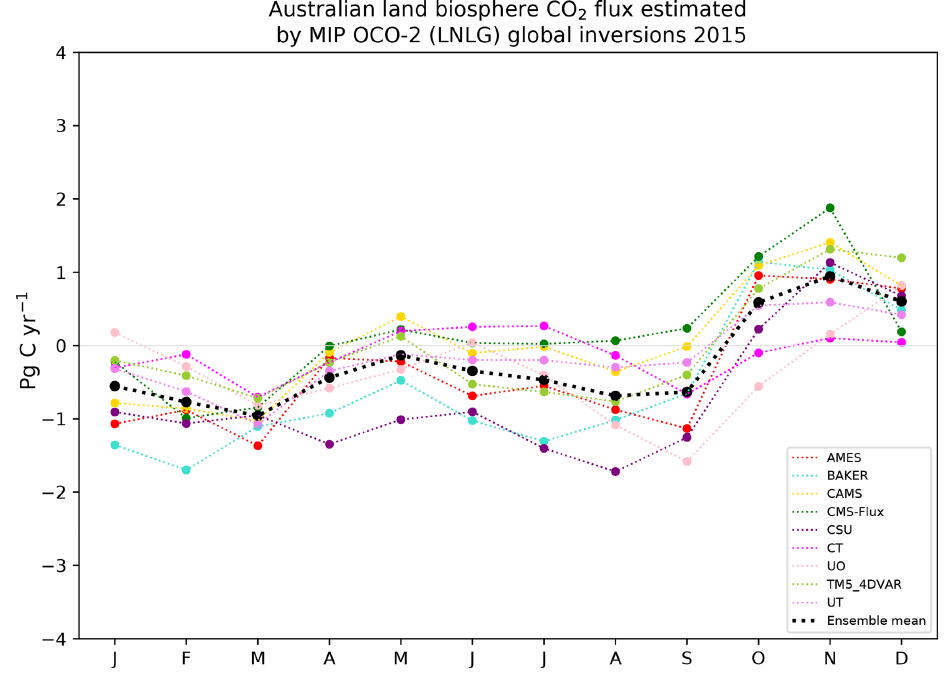
Figure I2. Time series of monthly mean carbon fluxes derived by OCO-2 MIP (LNLG) global inversion for 2015.